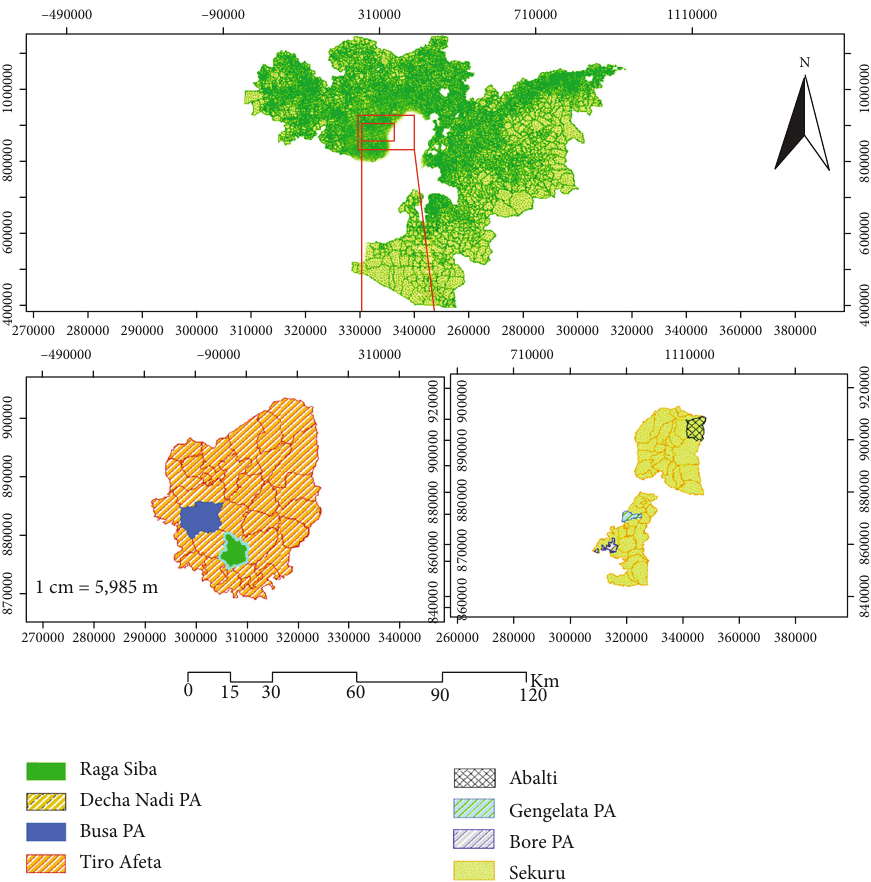
Figure 1: Map of the study districts.